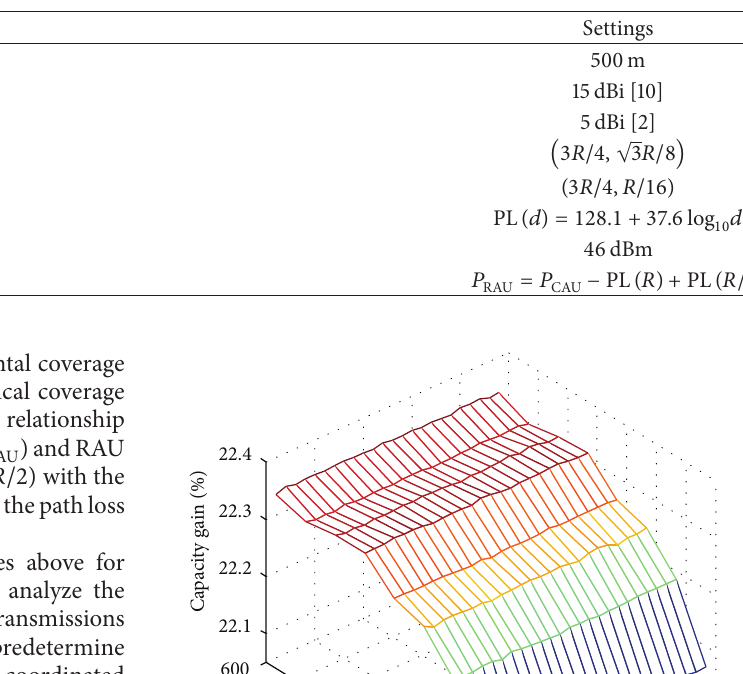
Table 1: Simulation parameters and settings.